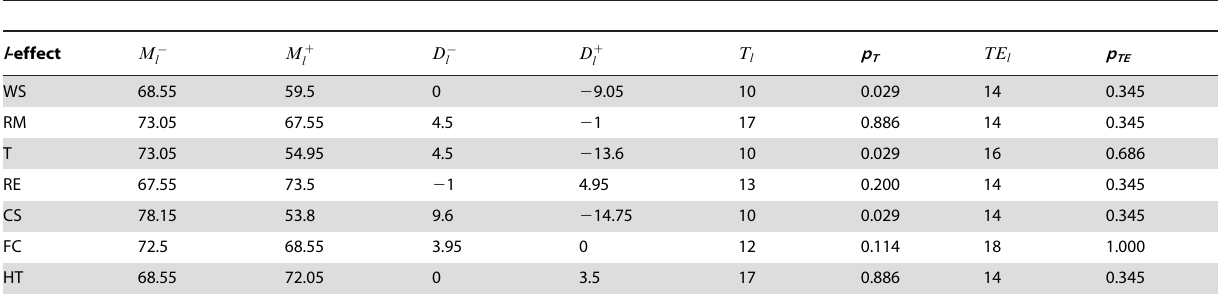
Table 3. Order stochastic estimations for filtration data from Table